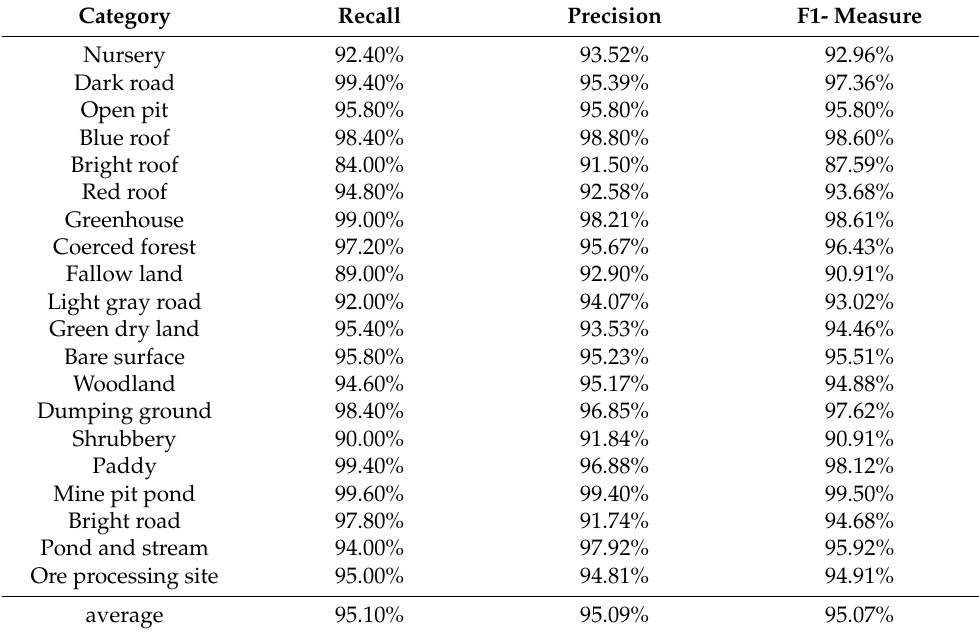
Table 3. Classification results from the multi-level deep belief network model for various feature